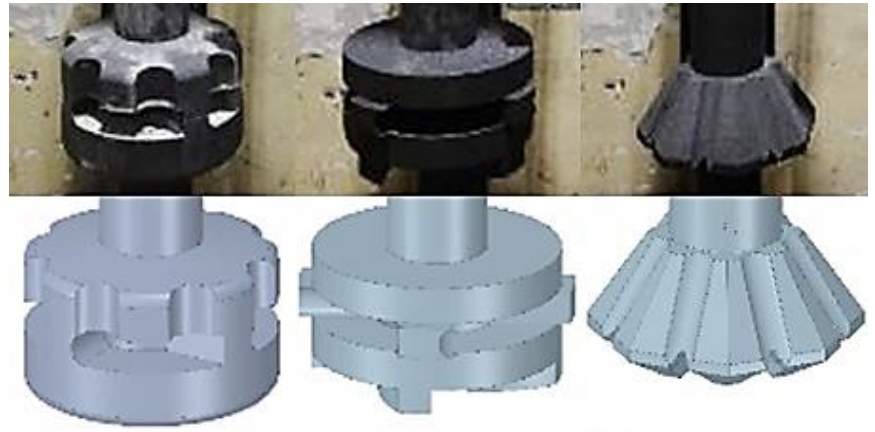
Figure 2. Rotors geometry. Table 3. Type A rotor—setting of refining technological parameters.